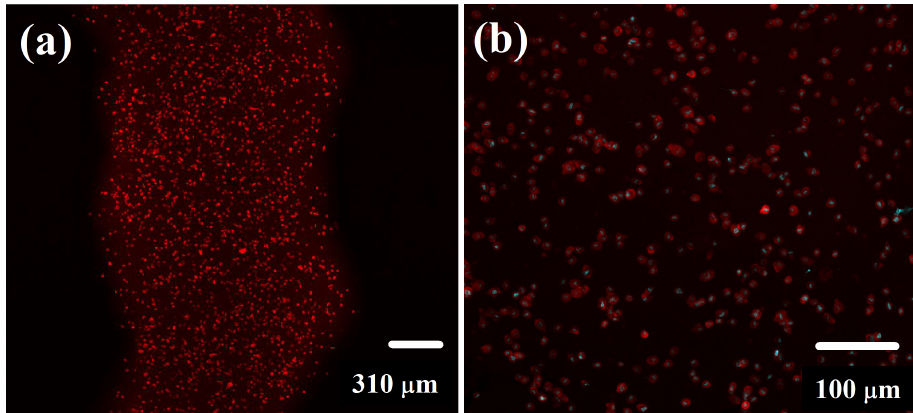
Figure 6. Microextruded Gel-B:Dex-Ox strand with incorporated mouse fibroblasts observed by the means of fluorescence confocal microscopy—( a ) 4 × magnification—image of cytoskeleton and ( b ) 10 × magnification—overlay of cell nuclei and cytoskeleton images.